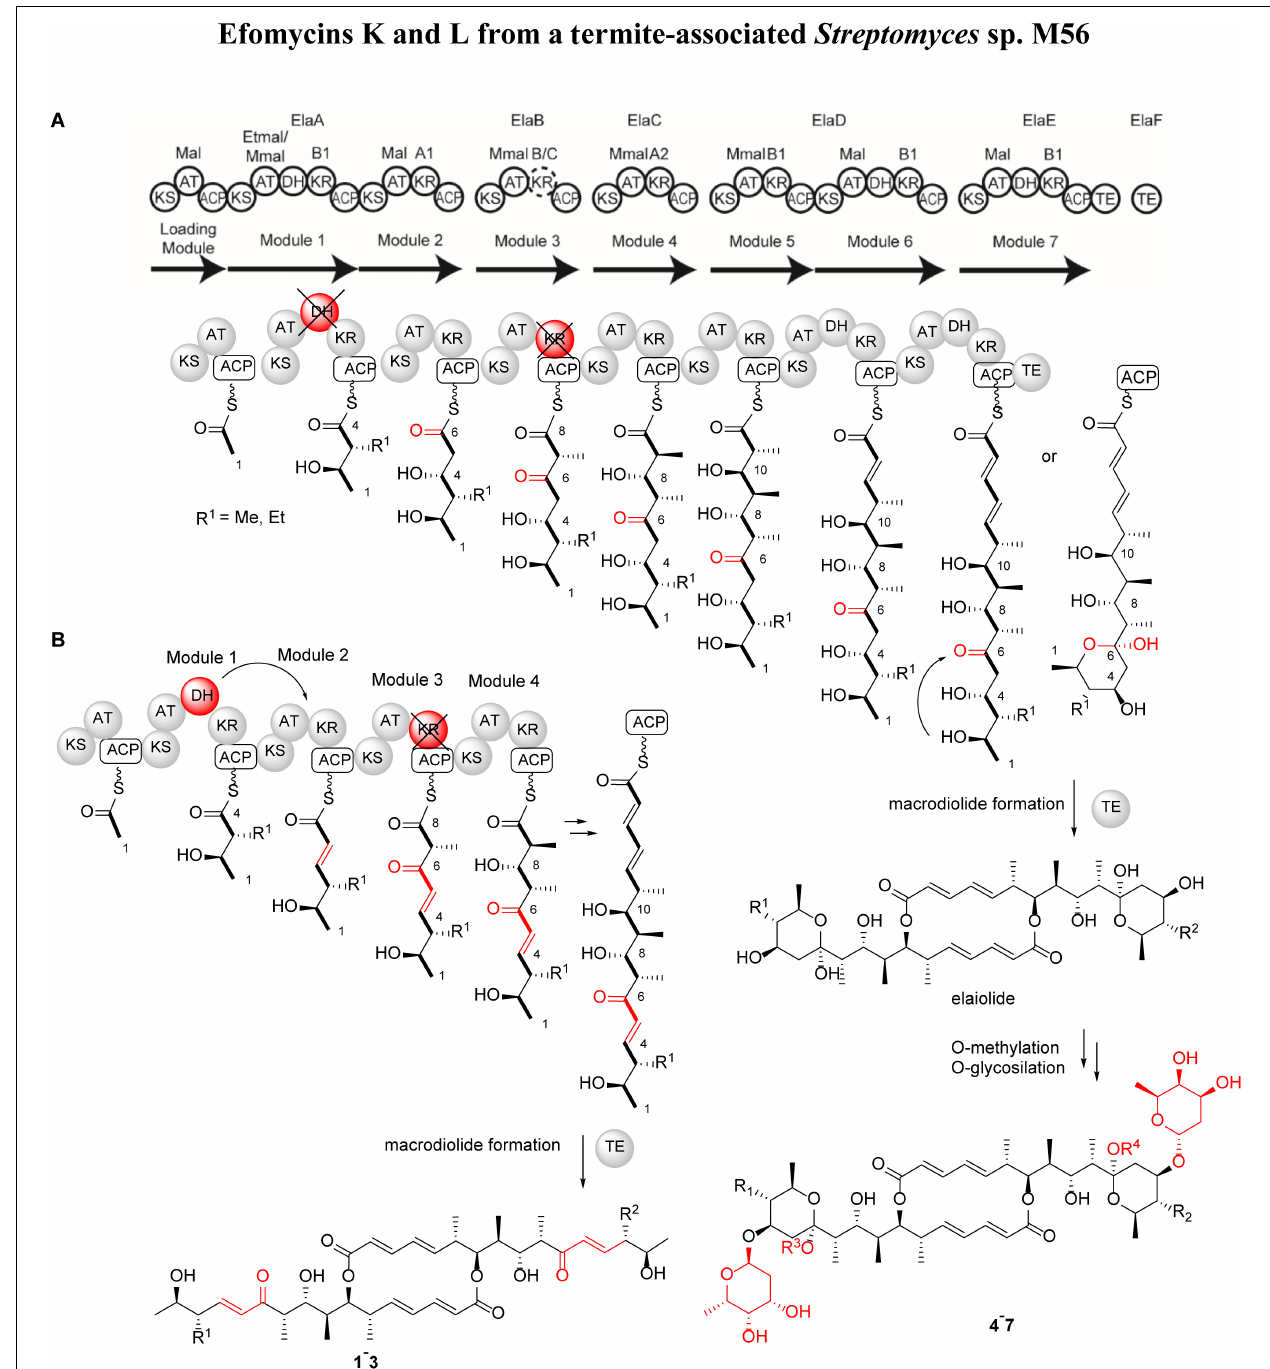
FIGURE 3 | Proposed efomycins ( 1–3 ) and elaiophylins ( 4–7 ) PKS assembly lines. Domain composition and specificity of the ela BGCs; the dimerization mechanism was adapted from Zhou et al. (2015b). Pathway (A) biosynthetic assembly line proposes an inactive ElaA-DH and ElaB-KR domains (colored in red). Pathway (B) biosynthetic assembly line proposes a trans -acting ElaA-DH and an inactive ElaB-KR domain (colored in